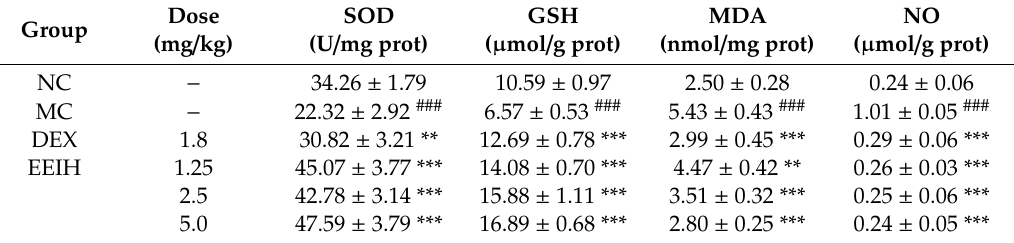
Table 6. E ff ects of EEIH on oxidative and nitrosative stress in renal tissue of LPS-treated mice. Group